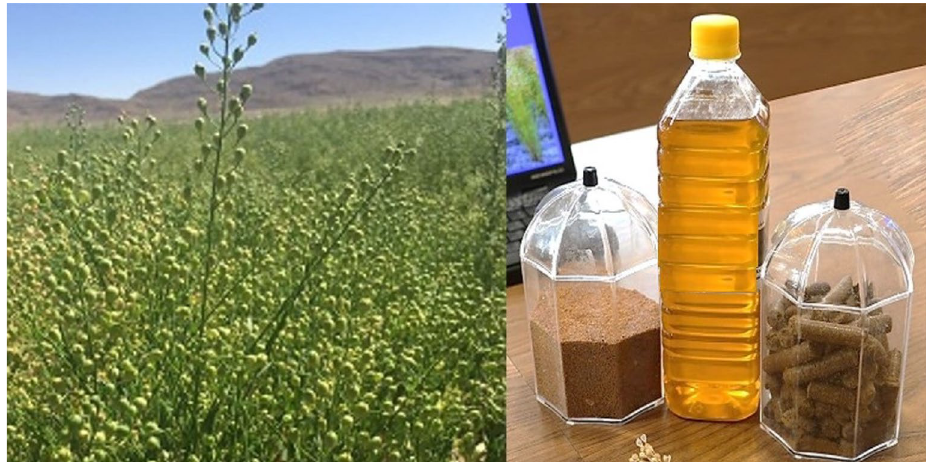
Figure 1. Camelina (Soheil cultivar): plant, seed, oil and oil